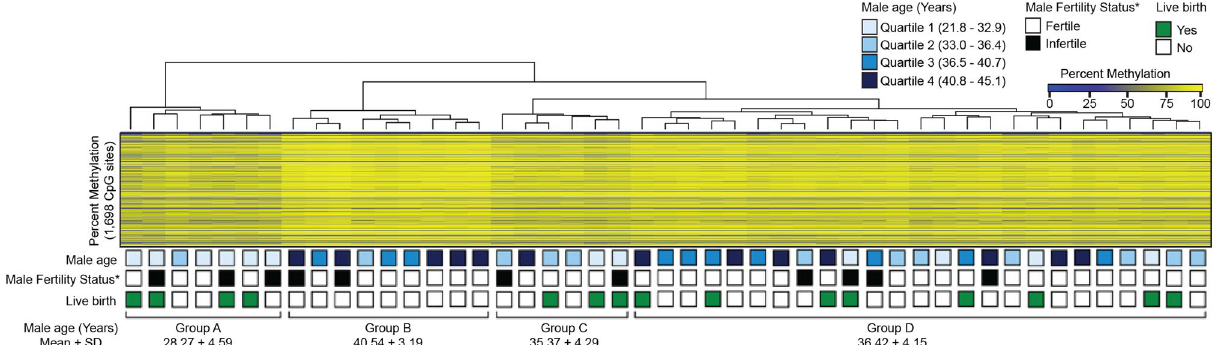
Figure 6. Unsupervised clustering of age-related sperm methylation at individual CpG sites (n = 1698). Boxes below the heatmap are color-coded representing individual-level data (n = 47) including quartiles of male age, male fertility status (fertile vs. infertile), and successful live birth (yes or no).